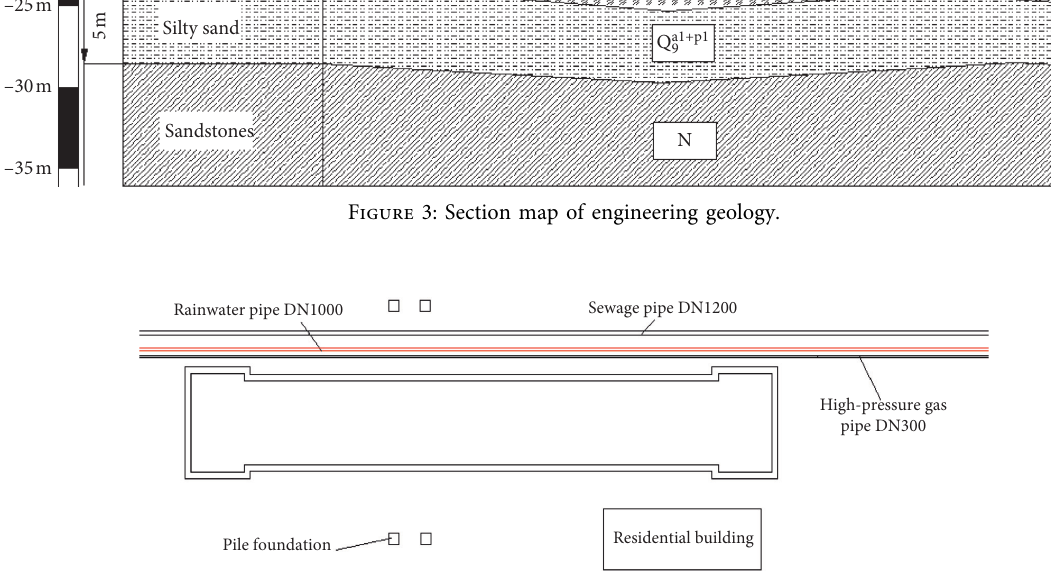
Figure 4: The layout of a subway